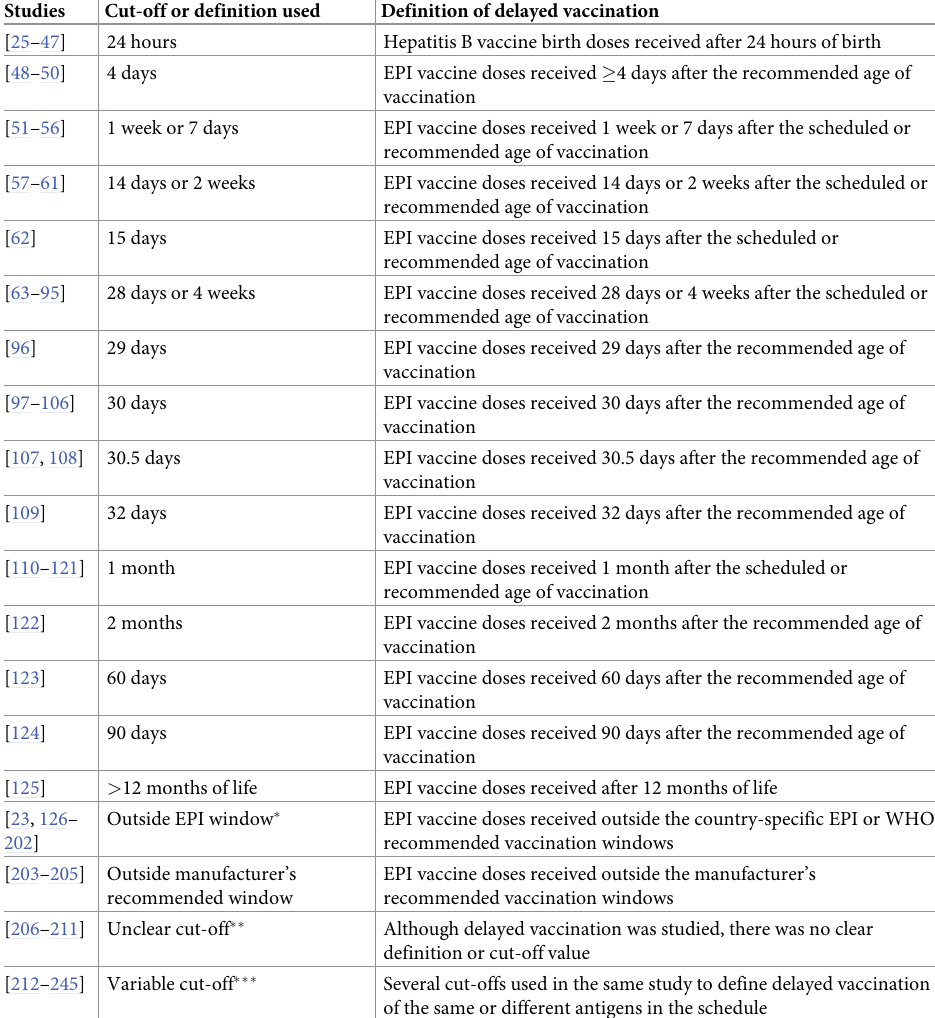
Table 1. How delayed routine childhood vaccination was defined in the 223 studies from LMICs that focused on this domain of timeliness, 1978–2021.